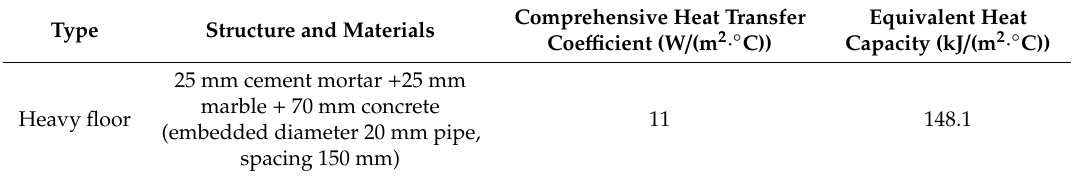
Table 4. Structure and material properties of RFHCS [33].